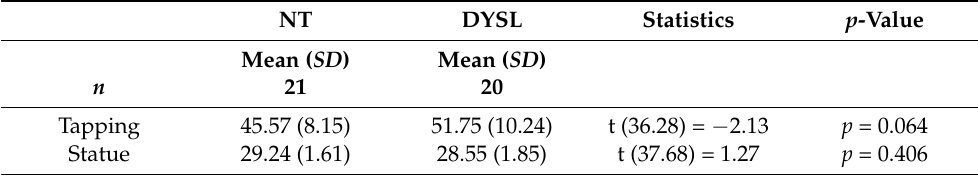
Table 7. Cerebellar